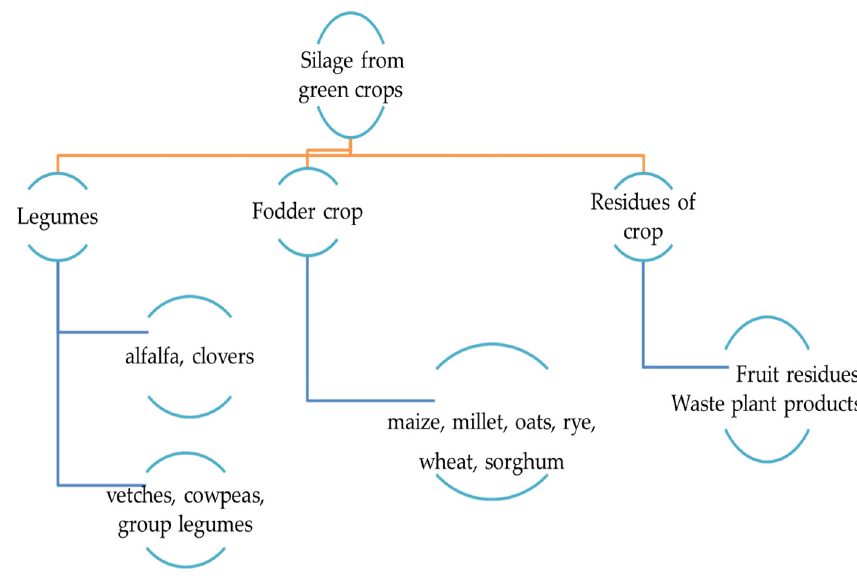
Figure 1. Sources of silages production from various crops. 2. Features and the Procedure in Producing Silage